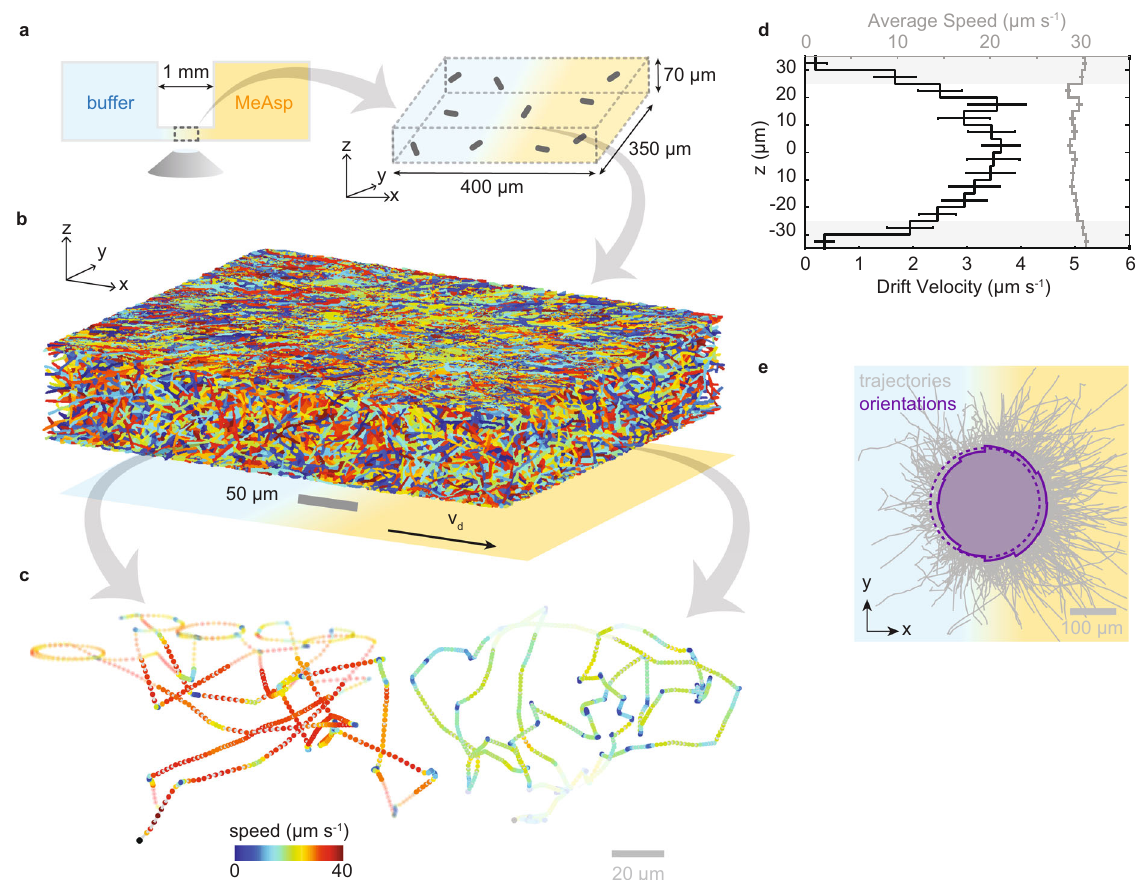
Fig. 1 Schematic of multiscale chemotaxis assay and its application to E. coli strain AW405. a A quasi-static linear chemical gradient is established between two reservoirs containing a uniform concentration of bacteria. Bacteria are observed in the central portion of the linear gradient starting 50 min after fi lling the reservoirs. b 5045 individual trajectories with a minimum duration of fi ve frames and containing 37,080 s of total trajectory time, obtained in 9 min of recording at 15 Hz in a typical experiment. c Two example trajectories (durations 63 and 65 s) showing run-tumble motility in bulk solution and circular segments near the chamber surface (within 10 µ m distance, faded). d Drift velocity (black, de fi ned as the average speed along the gradient direction, x ) and average swimming speed (gray) as a function of height, z , computed from three biological replicates of the experiment, comprising 9903 motile trajectories with a combined duration of 79,562 s. Only bulk trajectories (de fi ned as trajectory segments with a distance of more than 10 µ m to the surface) are retained for further analysis. Error bars re fl ect standard errors of the mean. e Bulk trajectories from the same dataset with aligned origins (gray) and polar probability distribution of instantaneous swimming directions projected in the x-y plane (purple, solid line). A fl at distribution (dashed) is shown for reference. For visual clarity, only those 7688 trajectories with a minimal duration of 1 s are shown, comprising 24,755 s of trajectory data. The polar distribution of orientations is based on the full dataset (9294 trajectories with duration 26,329